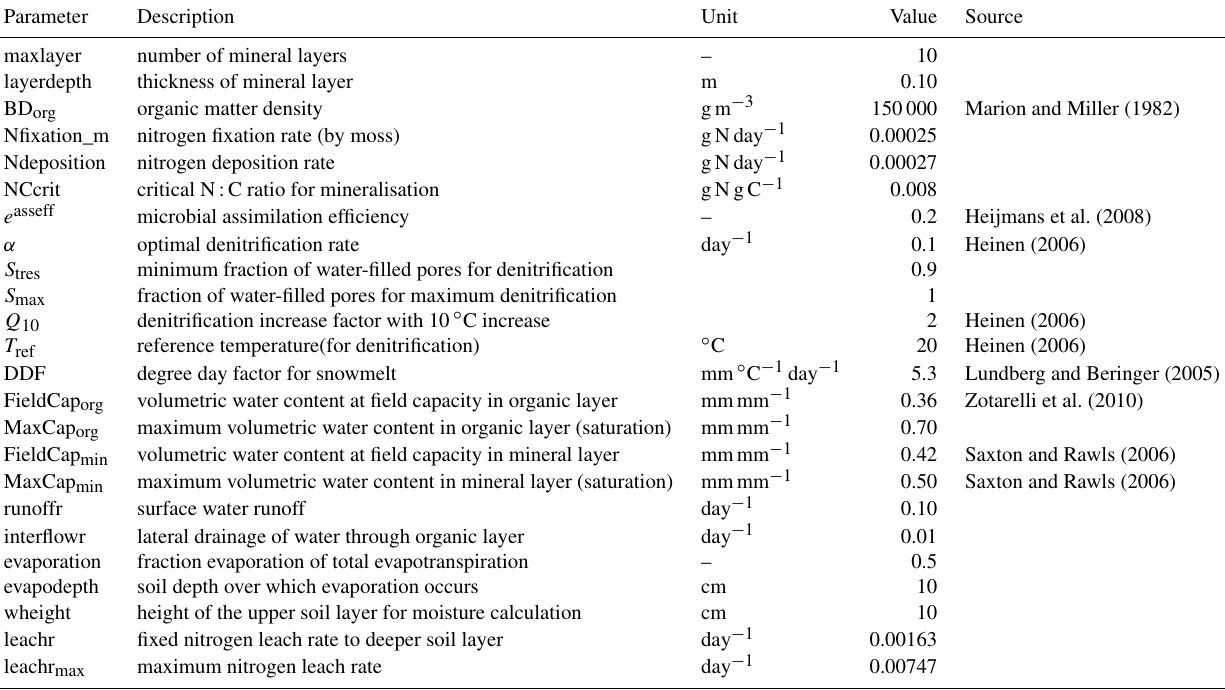
Table A2. Parameter values related to the soil profile, microbial processes and hydrology in NUCOM-tundra.